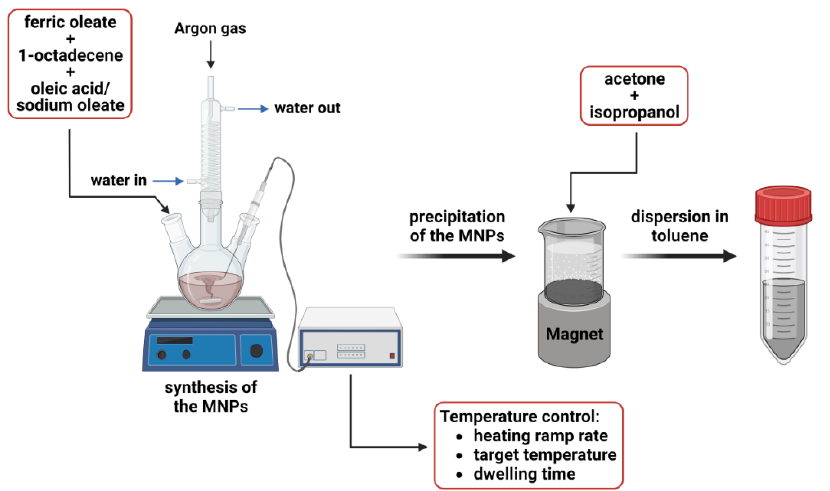
Figure 1. Schematic illustration of the magnetic nanoparticles synthesis strategies using the thermal decomposition method. Image “Created with BioRender.com”.